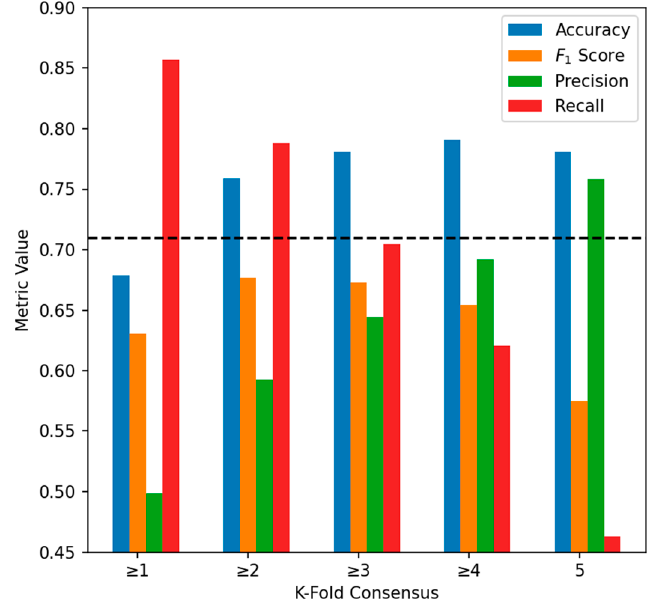
Figure 5. Verification overall accuracy, F 1 score, precision, and recall across k -fold consensus levels for the DNN- D 4 model figuration. The horizontal dashed line indicates our threshold for acceptable accuracy (>71%).